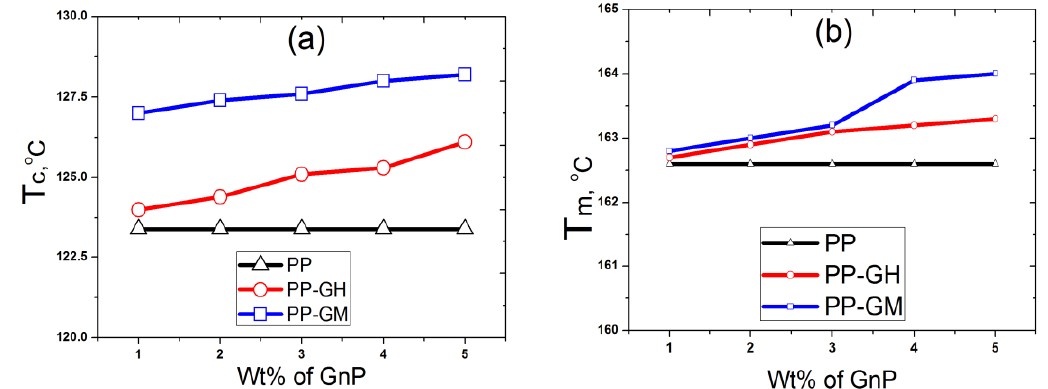
Figure 10. Variation of ( a ) crystallisation and ( b ) melt temperatures of the prepared nanocomposites with GNP content.